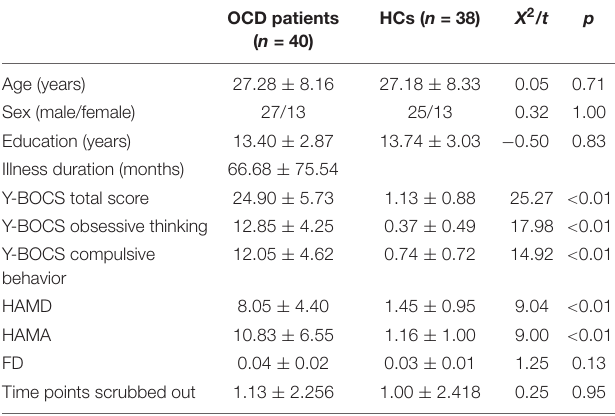
TABLE 1 | Demographic and clinical characteristics of